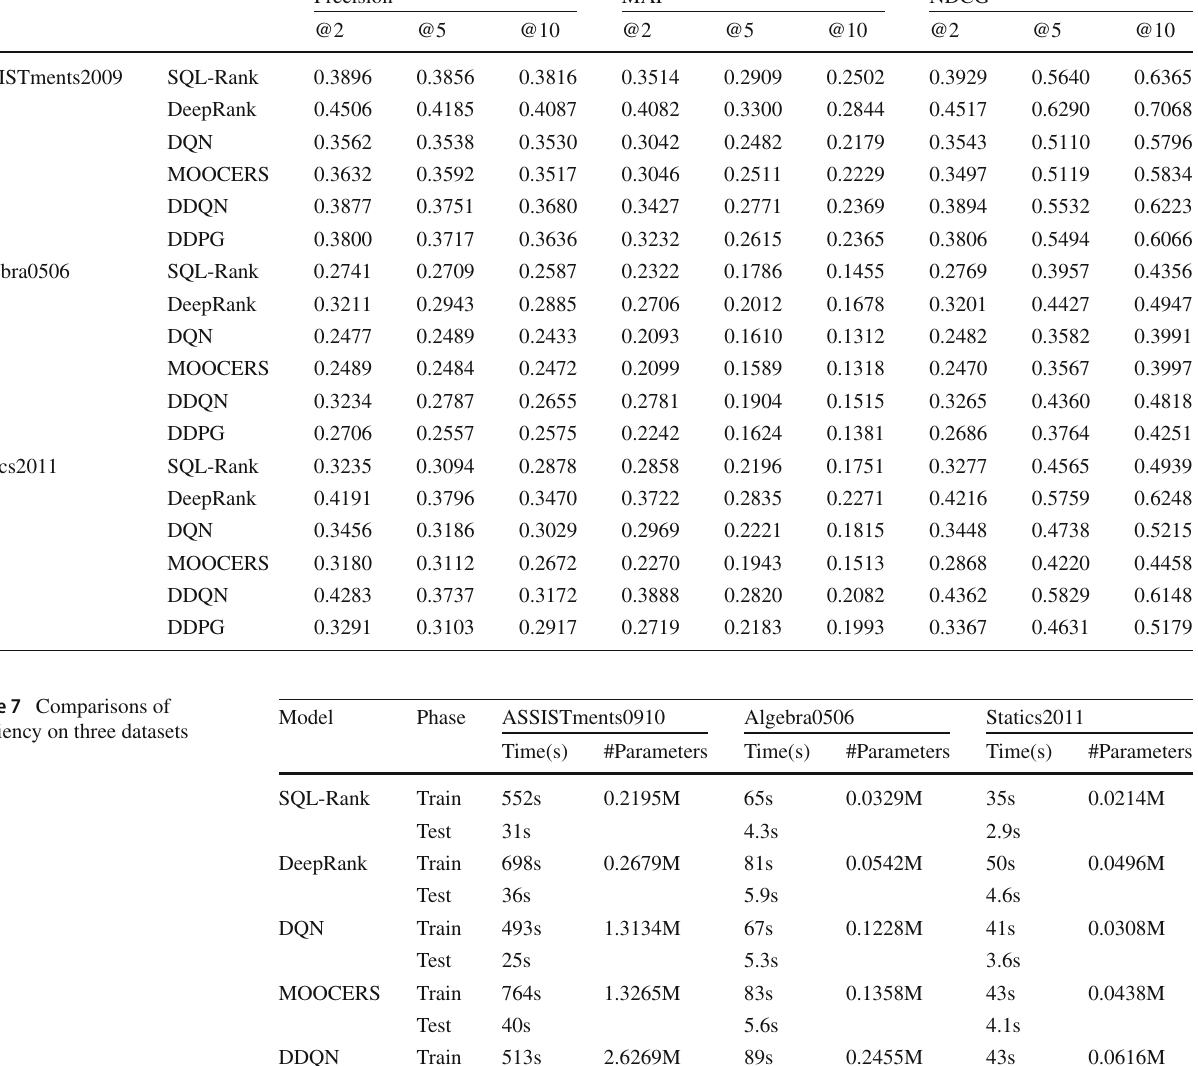
Table 6 Performance of comparison methods on different datasets